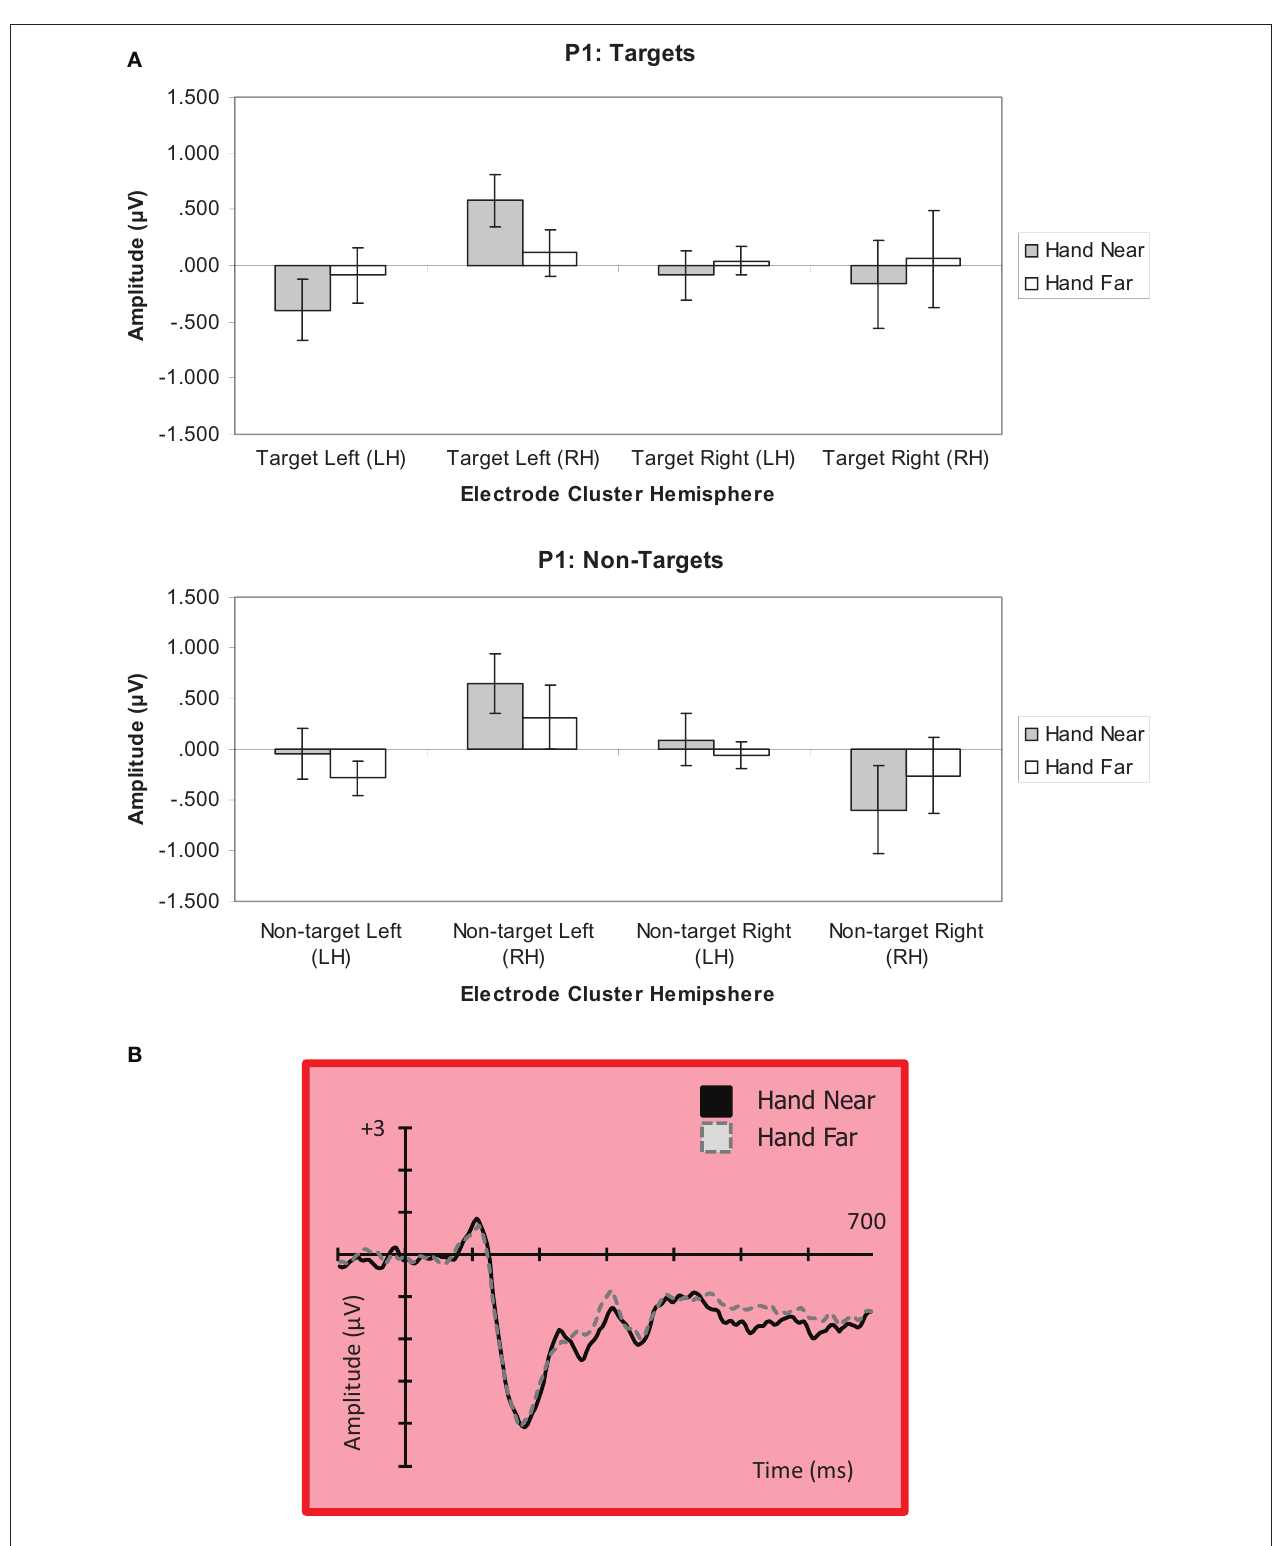
FIGURE 5 | (A) P1 (80–110ms) mean amplitudes ( µ V) comparing Near and Far conditions for left- and right-side targets and non-target stimuli in left (LH) and right hemisphere (RH) electrode clusters. Error bars represent standard error. (B) Grand average waveform for the P1 at